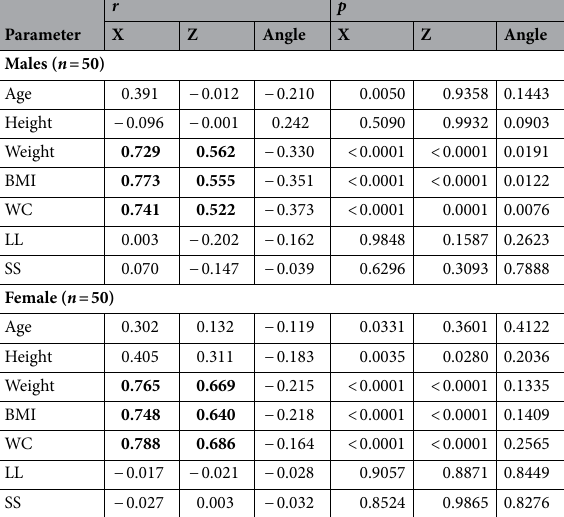
Table 2. Correlation between each explanatory variable and the X-value, Z-value, and lap belt angle by sex. Correlation coefficient ( r ) and p values are shown.